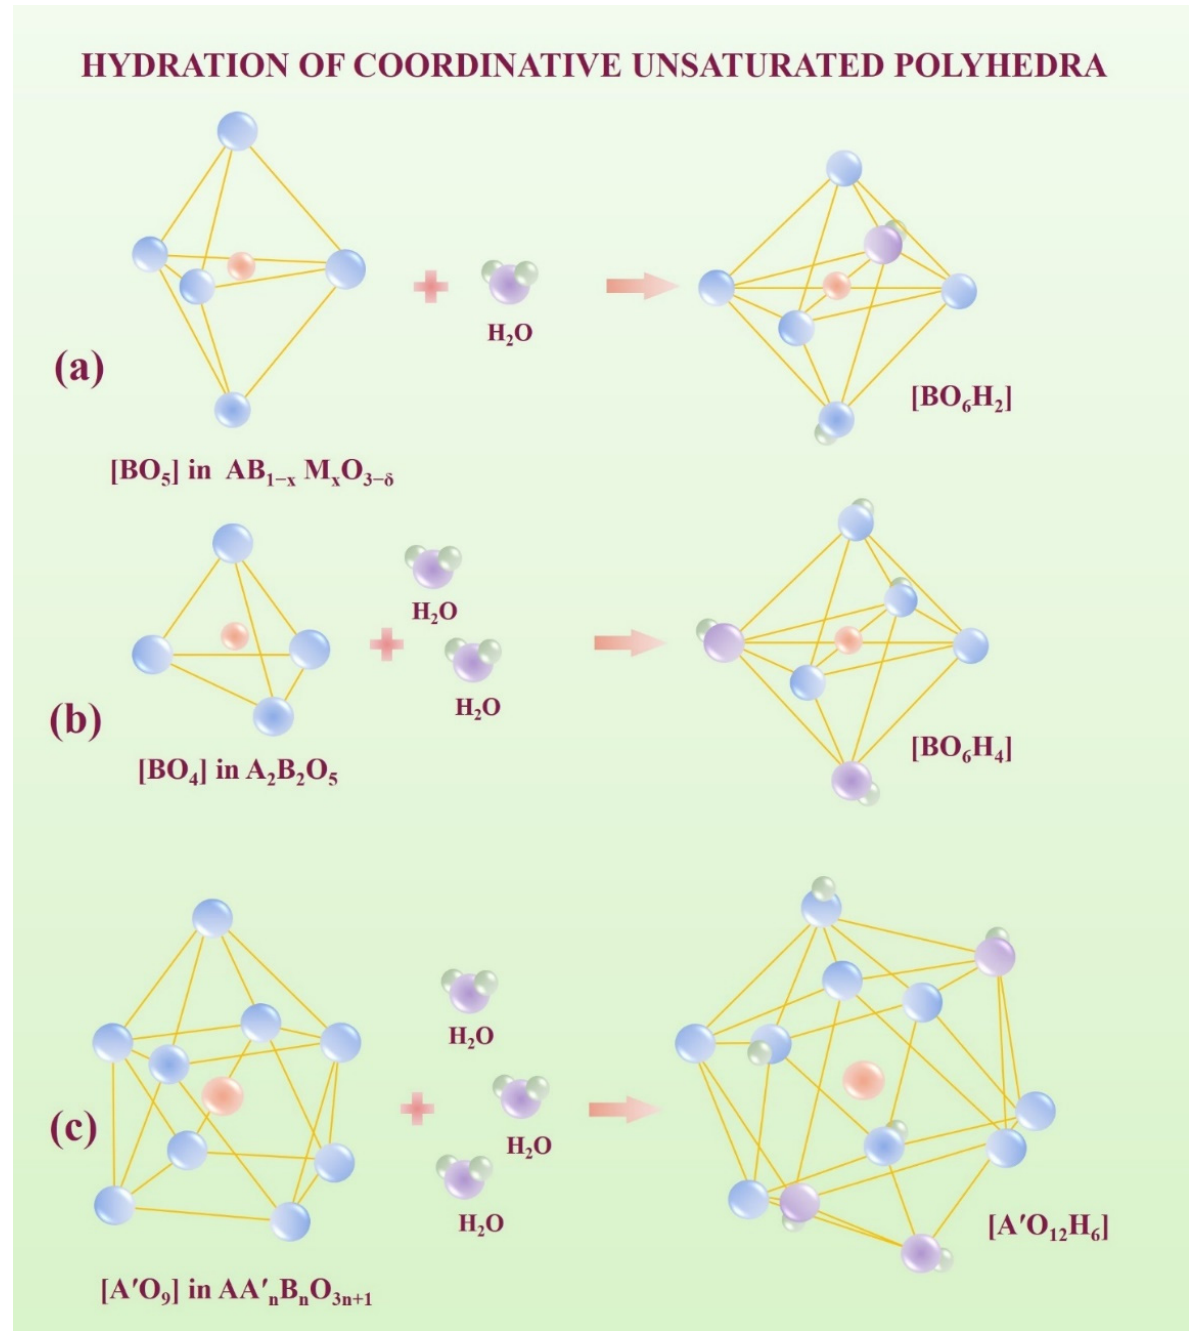
Figure 2. The hydration scheme of coordinative unsaturated polyhedra of acceptor-doped perovskite AB 1–x M x O 3– δ ( a ), brownmillerite A 2 B 2 O 5 ( b ) and layered perovskite AA ′ n B n O 3n+1 ( c ). As we can see, the shape of TG-curves and water uptake is almost the same for doped and undoped compositions. In the other words, the doping, which is accompanied by the appearance of oxygen vacancies in the structure and the expansion of the inter block space (increase of parameter c ), does not significantly affect the change in the water uptake. We can assume that increase in coordination number of coordinatively unsaturated atoms (La in BaLa 2 In 2 O 7 ) in two-layer structure is difficult compared to structurally flexible monolayer RP-perovskites and water uptake is comparable with water uptake for acceptor-doped classic perovskites (0.15–0.20 mol). Accordingly, the increase in proton conductivity